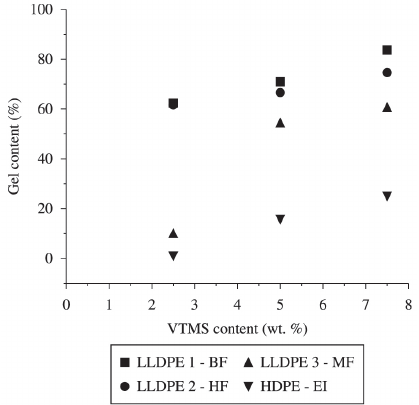
Figure 3. Gel content of crosslinked